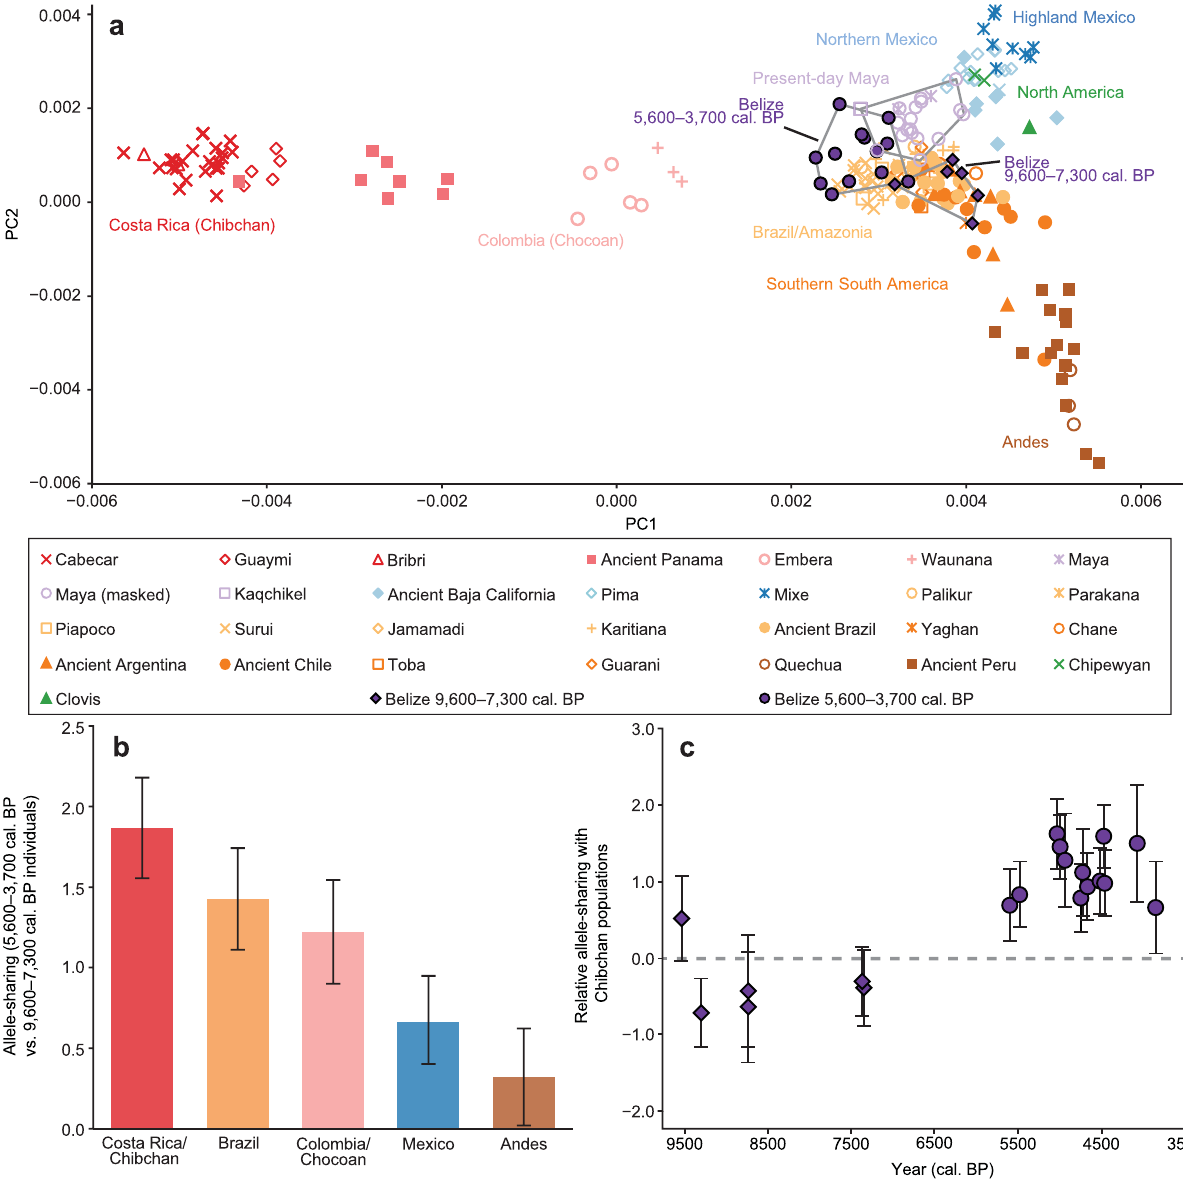
Fig. 2 Genome-wide analyses of MHCP and ST individuals compared to present-day populations. a PCA. Axes were computed using Maleku and Teribe (Chibchan), Zapotec (highland Mexican), and Aymara (Andean), and all individuals shown were projected (MHCP.14.2.4c was omitted due to low coverage). Alternative PCA plots can be found in Supplementary Fig. 23. b Allele-sharing statistics of the form f 4 (9600 – 7300 cal. BP, 5600 – 3700 cal. BP; Outgroup, X ) (multiplied by 1000) for present-day geographic/linguistic groupings X (Chibchan: Guaymi, Maleku, and Bribri; Chocoan: Embera and Waunana; Brazil: Karitiana and Surui; Mexico: Mixe, Mixtec, and Zapotec; Andes: Aymara and Quechua). c Allele-sharing statistics of the form f 4 (Aymara, Chibchan; Outgroup, X ) (multiplied by 1000) for the ancient Belize individuals X (Chibchan as in b ). Values were computed on 305,133 SNPs. Bars show one standard error in each direction around the mean ( b and c